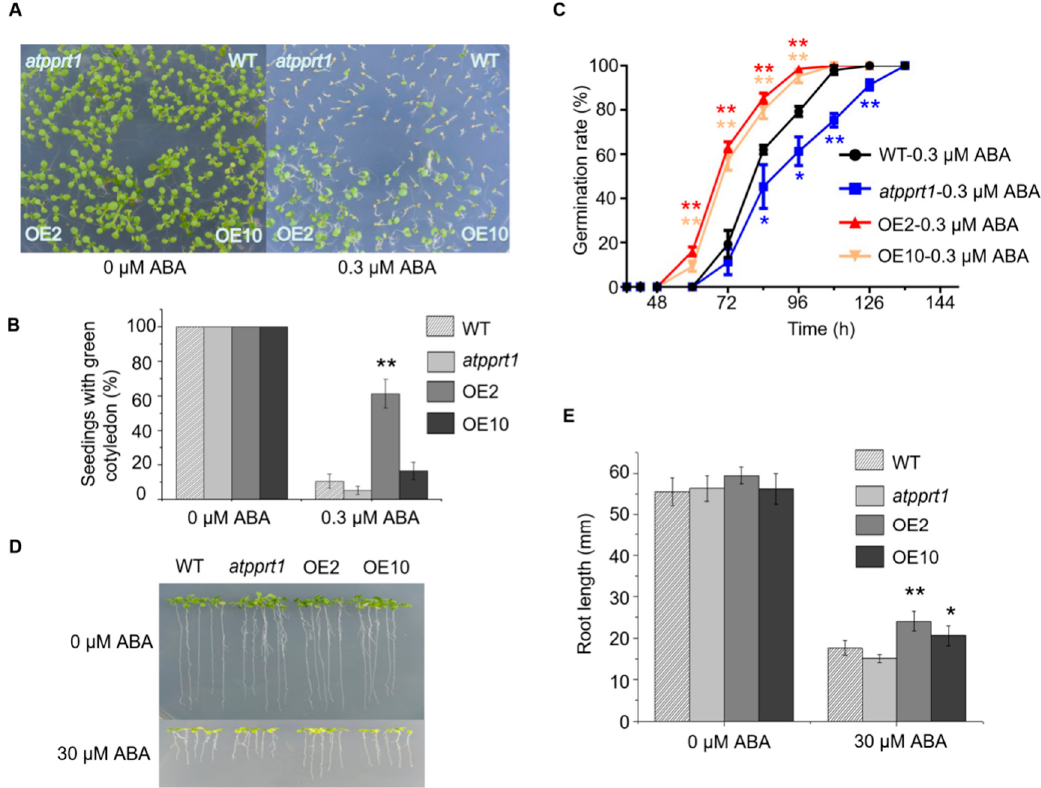
Figure 4. AtPPRT1 acted as the negative regulator in Arabidopsis signaling pathway. ( A , B ) Phenotype and green cotyledon rates of WT, atpprt1 , OE2, and OE10 grown for 7 days on MS or MS supplemented with 0.3 µ M ABA; ( C ) Germination rates of each line grown on MS supplemented with or without 0.3 µ M ABA. Error bars represent ± SD ( n = 50, * p < 0.05 and ** p < 0.01, t -test); ( D , E ) Phenotype and root length of WT, atpprt1 , OE2, and OE10 planted 3 days on MS following 7 days vertical culture on MS or MS supplemented with 30 µ M ABA. The values are the average of three individual biological replications. Error bars represent ± SD ( n = 21, * p < 0.05 and ** p < 0.01, t -test).